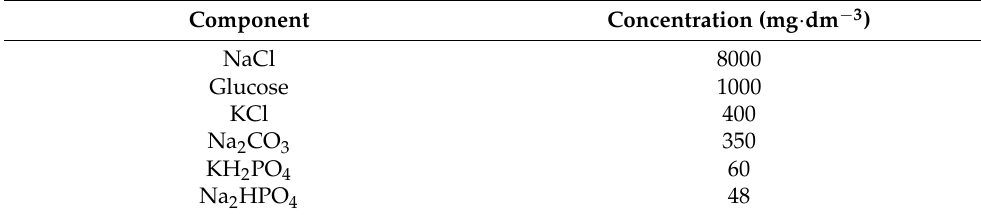
Table 2. Chemical composition of used SBF